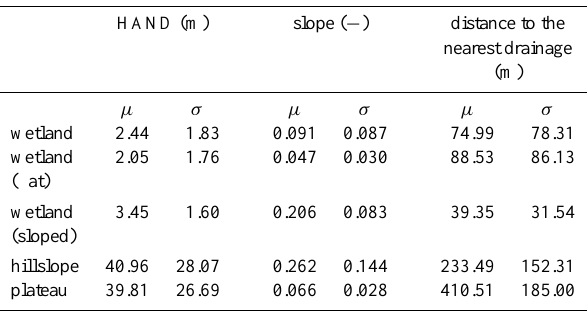
Table 2. Mean and standard deviation values for HAND, slope and distance to the nearest drainage for each landscape class of the best model performance M SHopt (threshold values H =4.7m, S